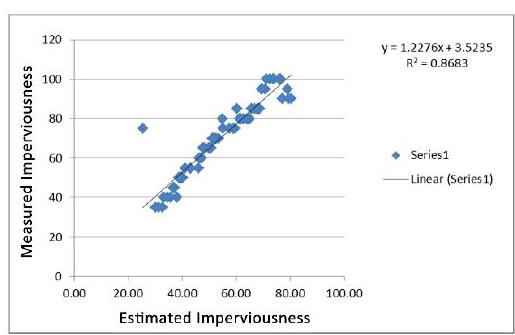
Figure 10 . Relation between Measured and Estimated Impervious Surface Percentage